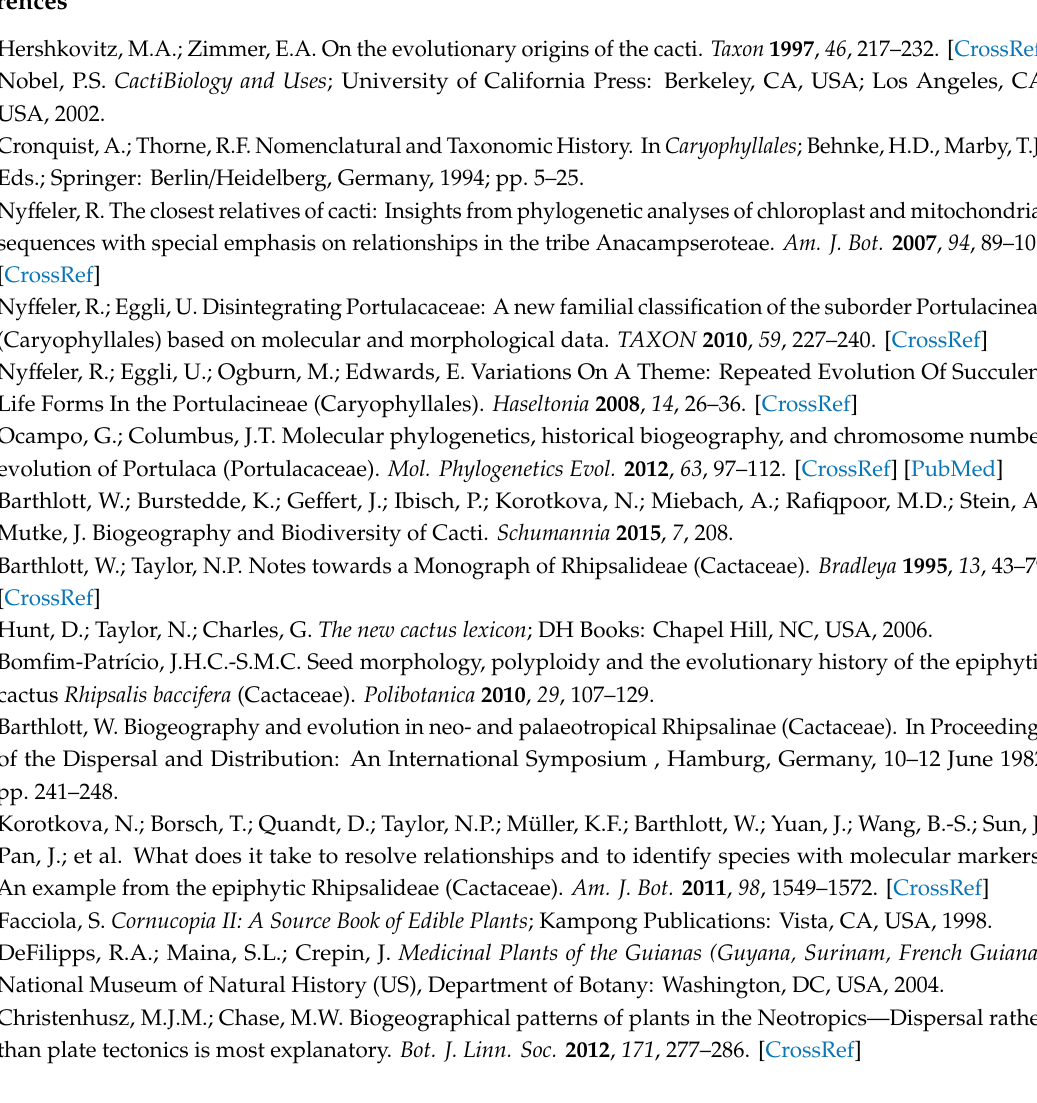
Figure S1: Genome structural alignment of order Caryophyllales species, Figure S2: Phylogenetic analysis of thirty six species order Caryophyllales using maximum likelihood (ML), Figure S3: Phylogenetic analysis of thirty six species order Caryophyllales using Bayesian method, Table S1: Complete chloroplast genomes used in phylogenetic analysis, Table S2: Codon usage in the chloroplast genome of Rhipsalis baccifera , Table S3: Table showing the frequency of repeats and their location in chloroplast genome of Rhipsalis baccifera , Table S4: Table showing the types of SSR repeats found suborder